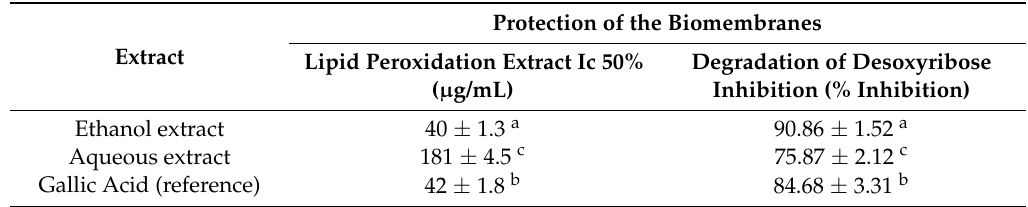
Table 2. Results of inhibition of lipid peroxidation and degradation of deoxyribose.